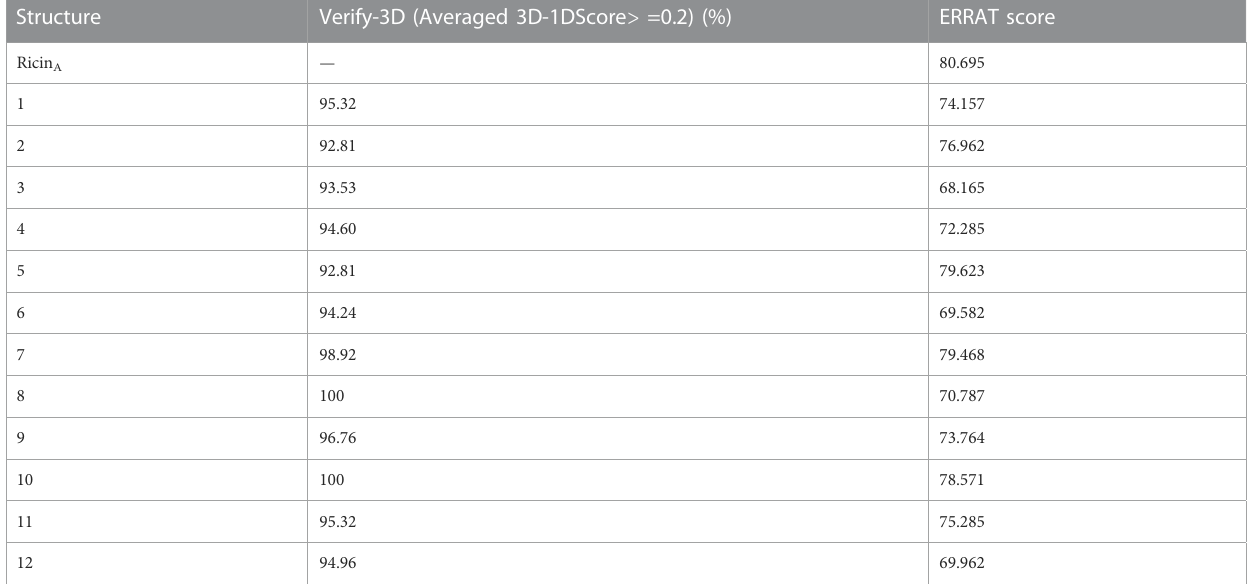
TABLE 1 Validation of the predicted CPs by Verify-3D and ERRAT scores.